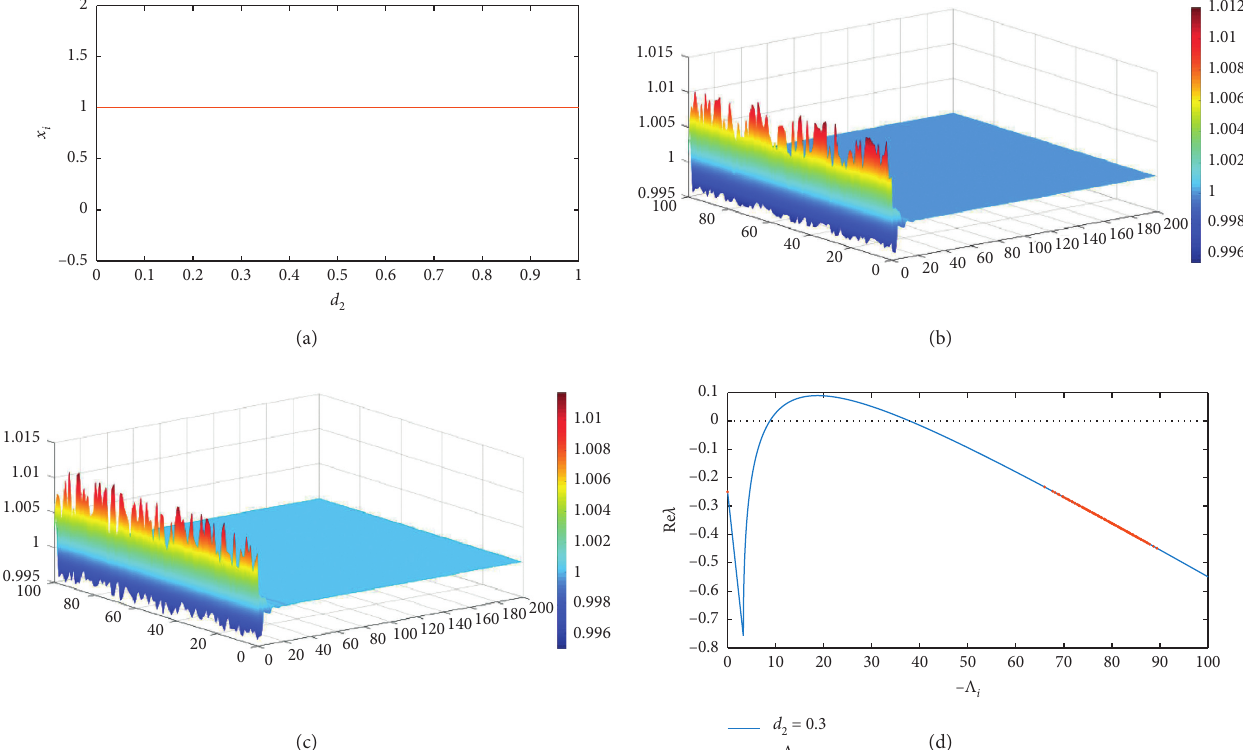
Figure 13: (a) The bifurcation diagram of d